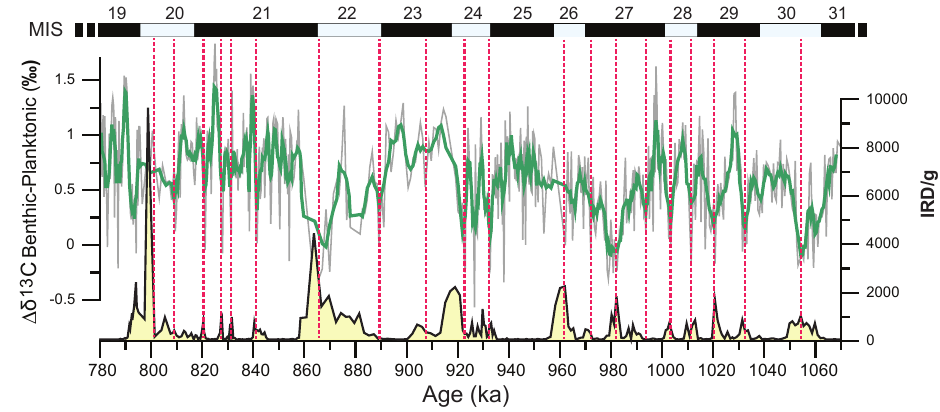
Figure 4. Data for IODP Site U1314 spanning MIS 31–19 vs. age. (a) (cid:49)δ 13 C b − p (b: benthic (i.e. C. wuellerstorfi and M. pompilioides ), p: planktonic N. pachyderma (sin)); (b) IRD/g (Hernández-Almeida et al.,